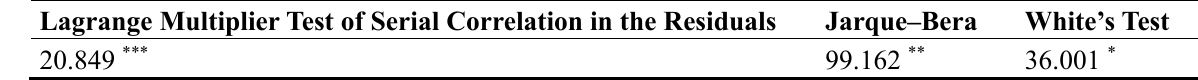
Table 8. Specification and diagnostic tests.